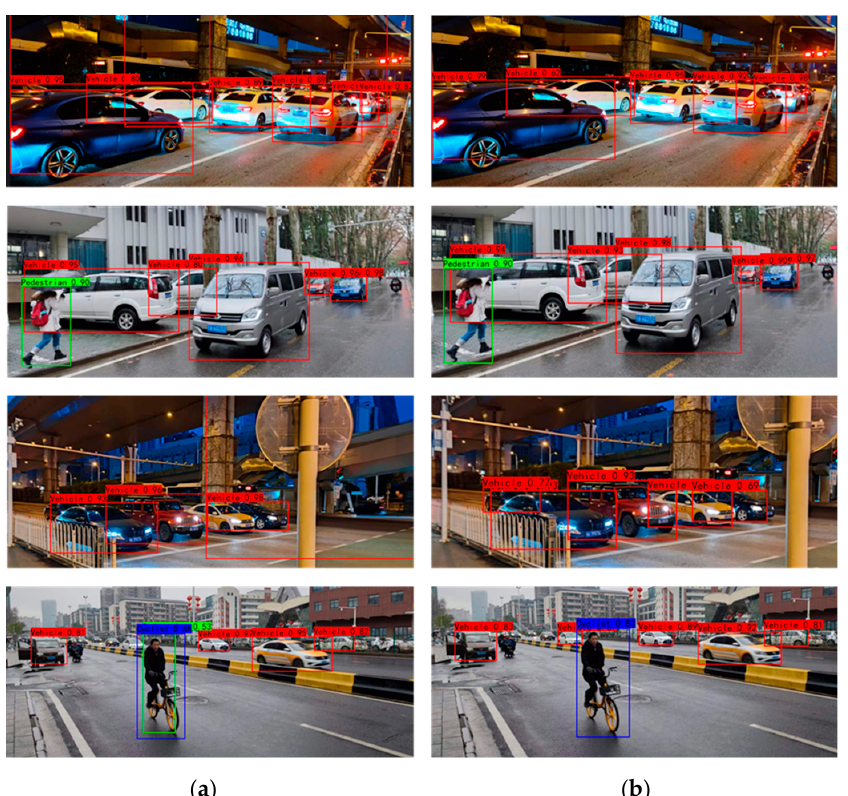
Figure 19. Object detection results of collected data: ( a ) YOLOv4; ( b ) VV-YOLO.